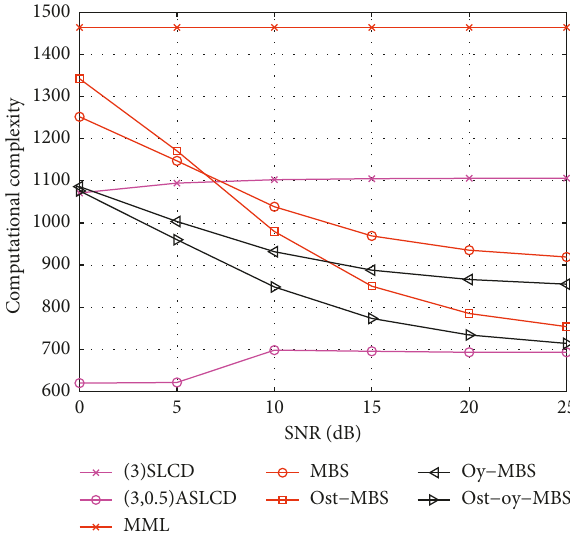
Figure 5: The computational complexity of the proposed detectors 8 ,N R 4, and 16QAM with N T (cid:31) (cid:31)